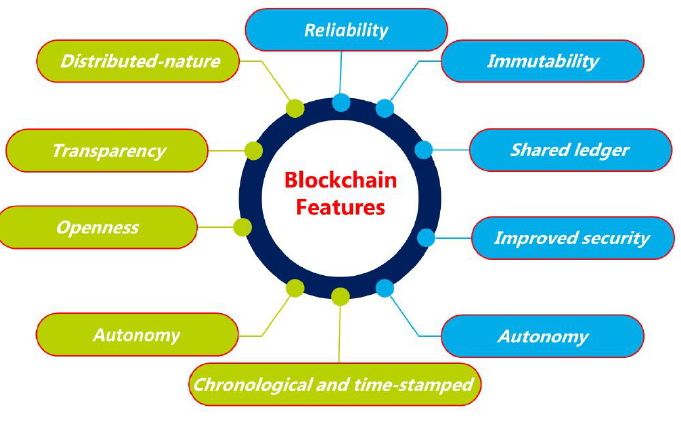
Figure 5. Blockchain